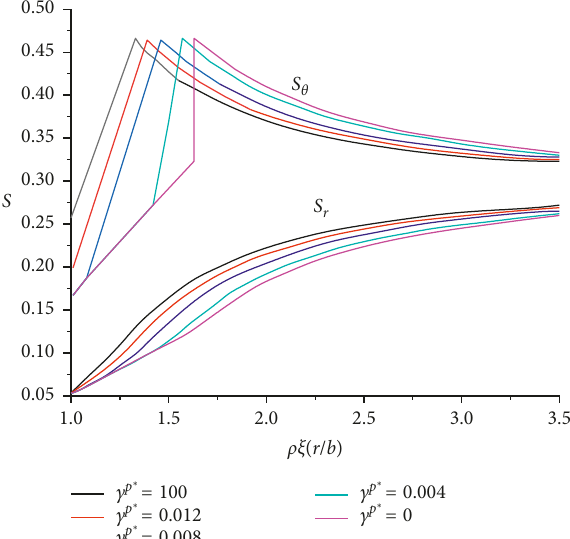
Figure 8: Comparison of dimensionless stresses for M-C rock mass.